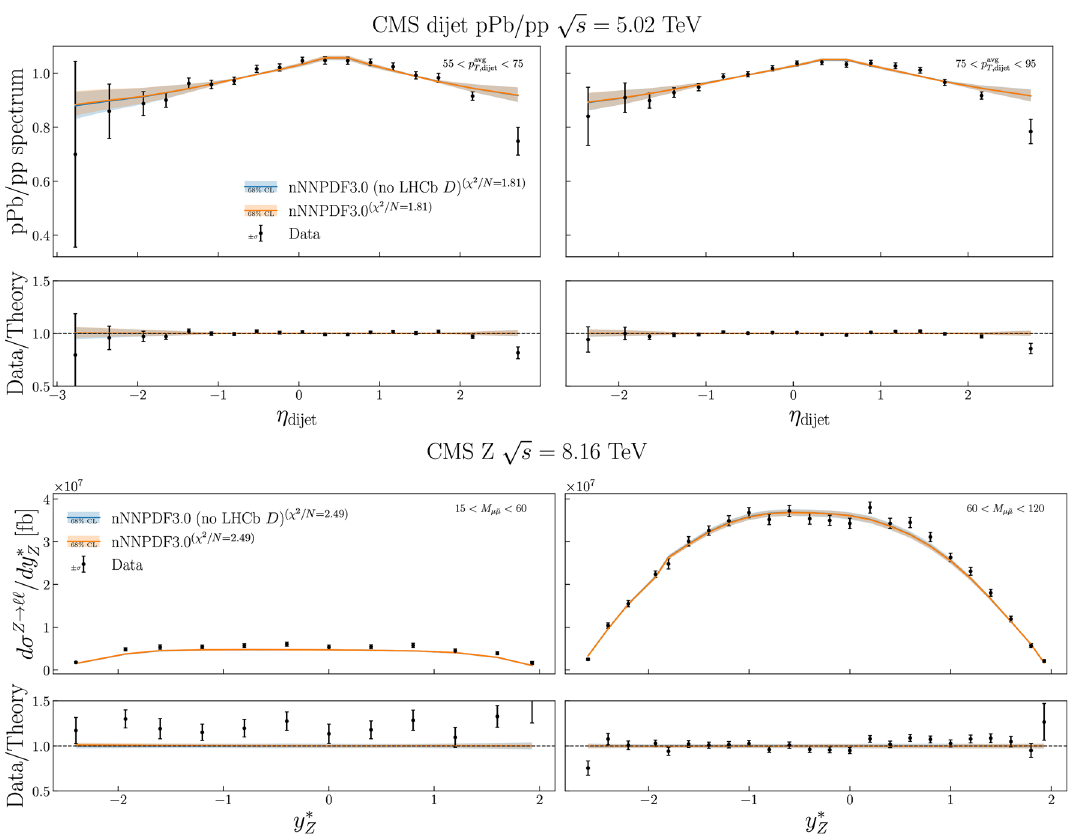
√ s = 5 . 02 TeV dijet production measurement (upper) and for the two dimuon invariant mass bins from the CMS measurement (bottom bins of the CMS T , dijet